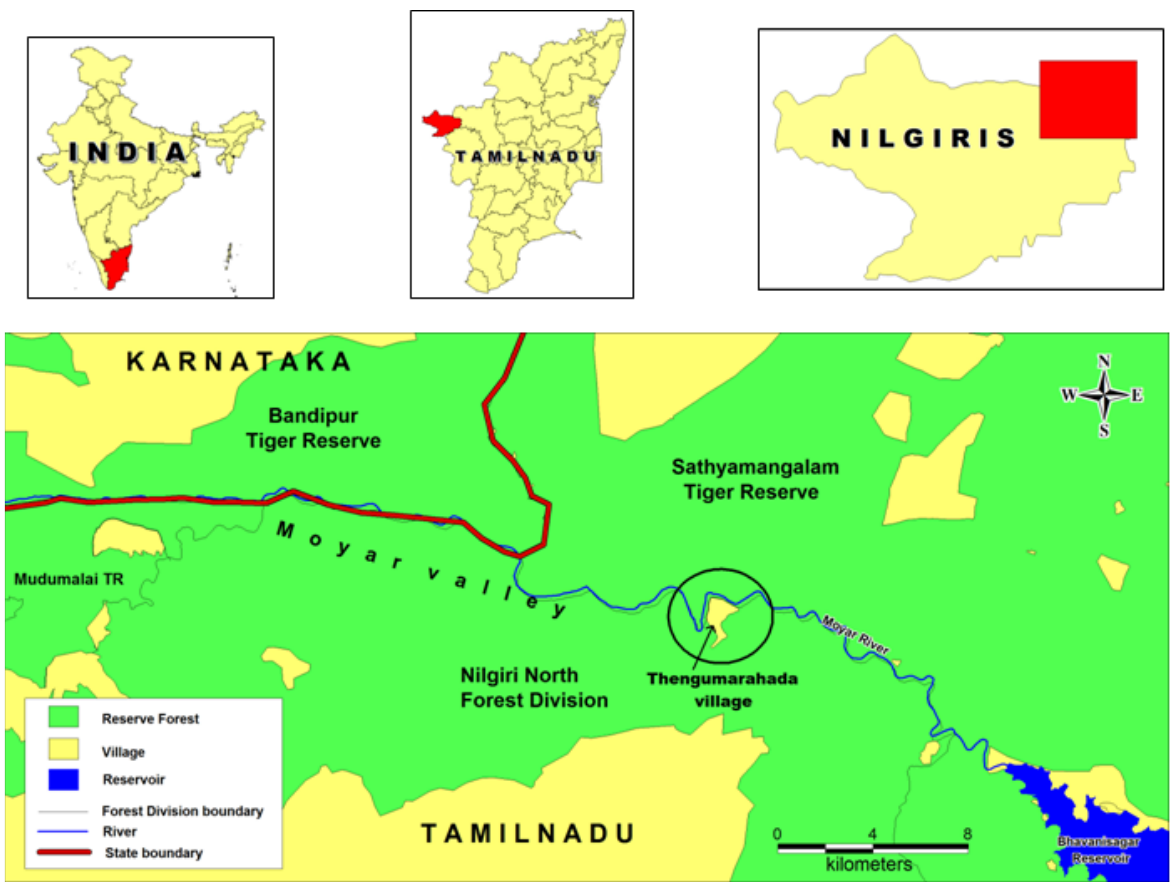
Figure 1. Location of Thengumarahada